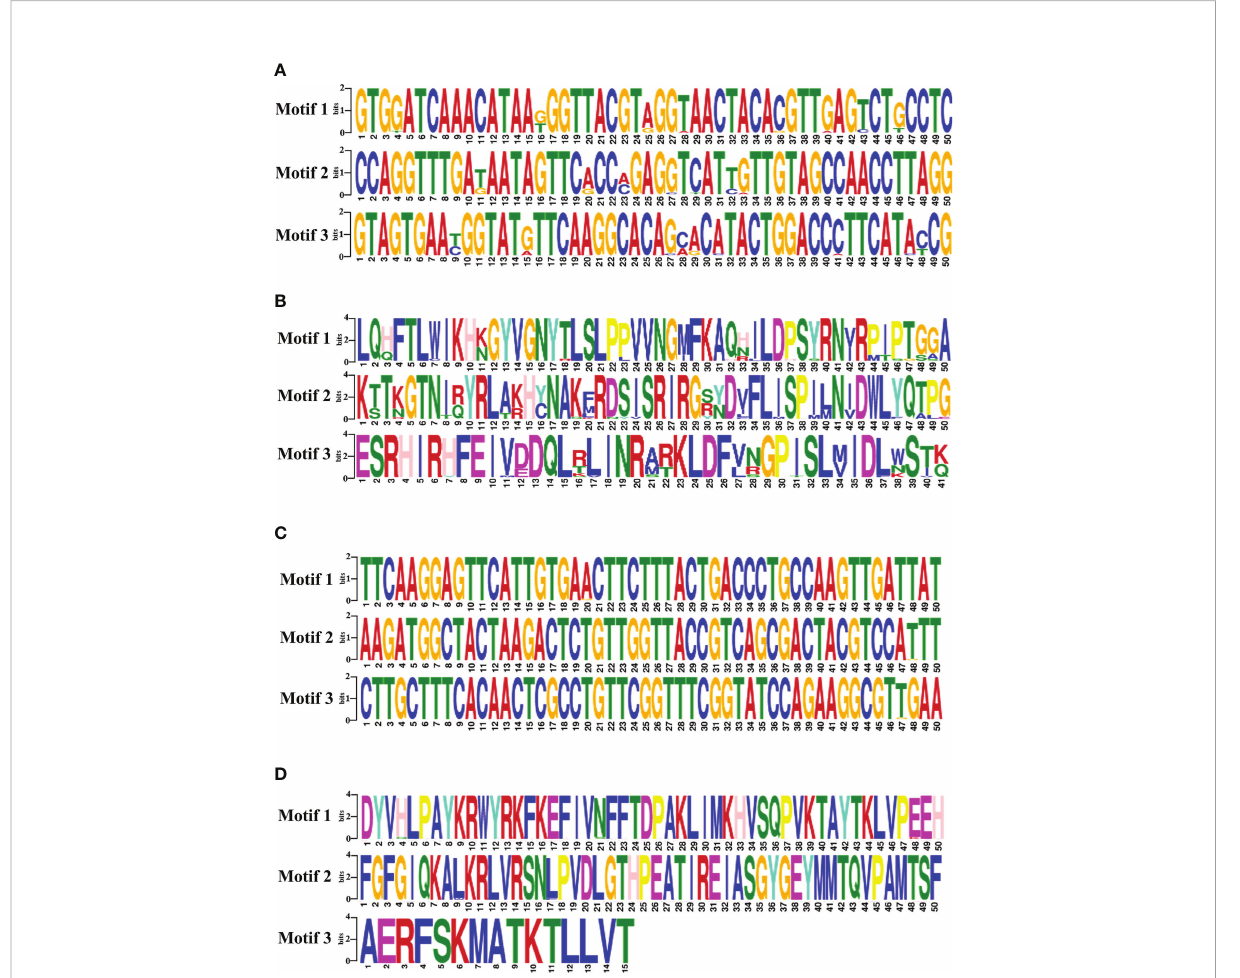
FIGURE 4 The motifs analysis of B bovis sbp-2 nucleic (A) and amino (B) acid sequences as well as B bigemina rap-1a nucleic (C) and amino (D) acid sequences.